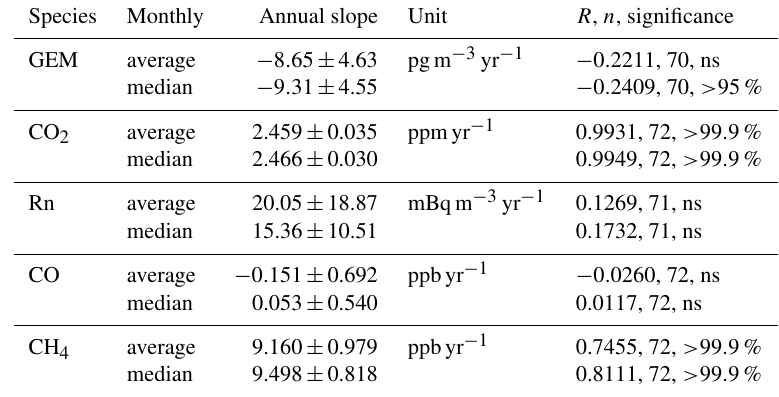
Table 3. Trends at Cape Point for the 2012–2017 period. Calculated by LSQF from monthly averages and medians.